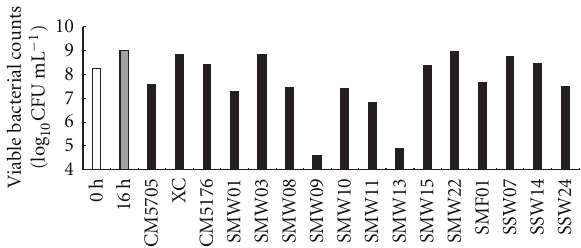
Figure 4: Viable bacterial counts of E. faecium WB2000 in single cultures at 0 and 16 h and in dual cultures with strains of mutans group streptococci at 16 h (log 10 CFU mL − 1